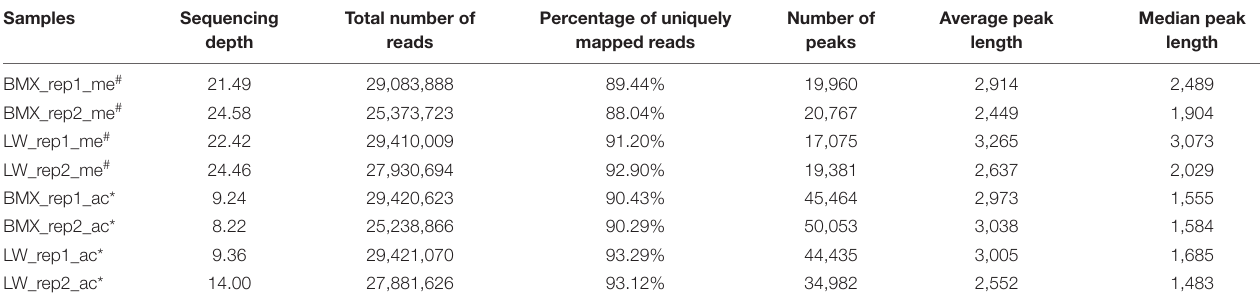
TABLE 1 | Summaries of ChIP-Seq experiments.